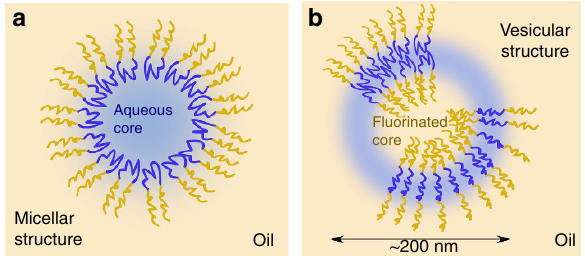
Figure 7 | The possible structures of the surfactant supramolecular assemblies. ( a ) The swolen micelle structure with an aqueous core, ( b ) the vesicle structure where the surfactant is either extended or forms bilayers. The vesicle structure is compatible with our experimental results. With the micelle structure, the exchange rate of water should depend on surfactant concentration and all dyes should have the same exchange rates (see Supplementary Fig. 4 and Supplementary Note